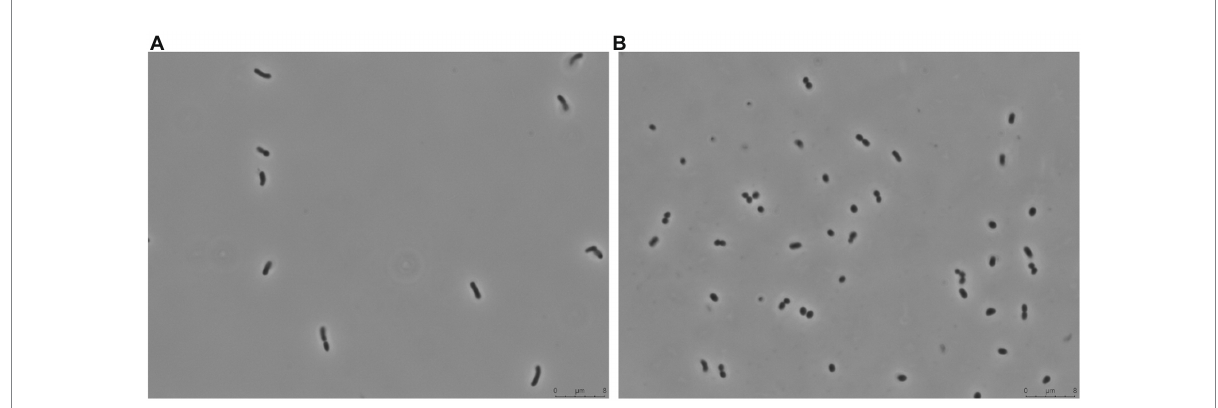
FIGURE 1 Phase contrast microscopy of Arthrobacter sp. Helios grown in LB at (A) exponential phase and (B) stationary